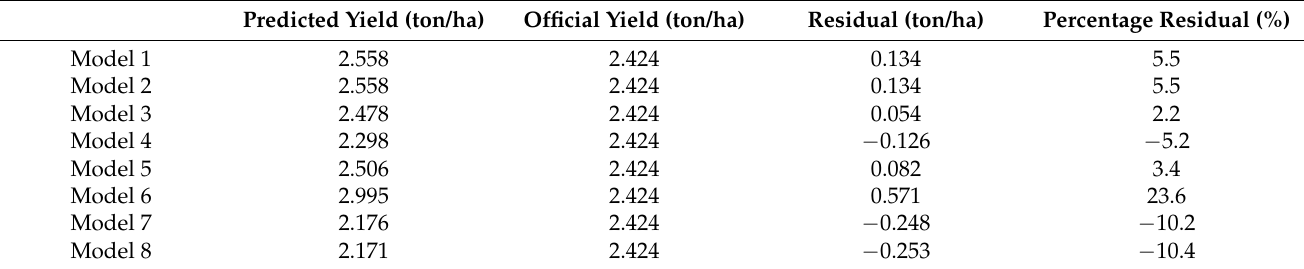
Table 4. Coffee yield predictions for 2020 based on each model. Predicted Yield